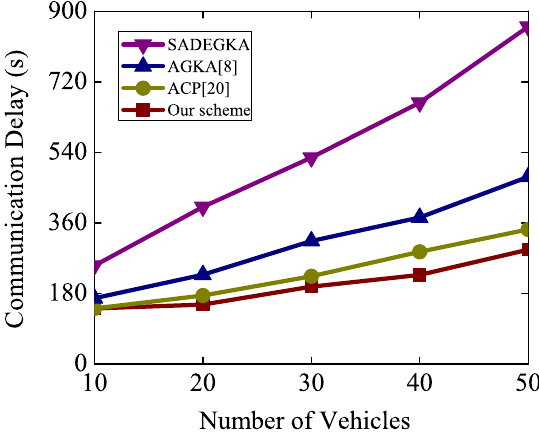
Figure 7. Number of vehicles versus computation